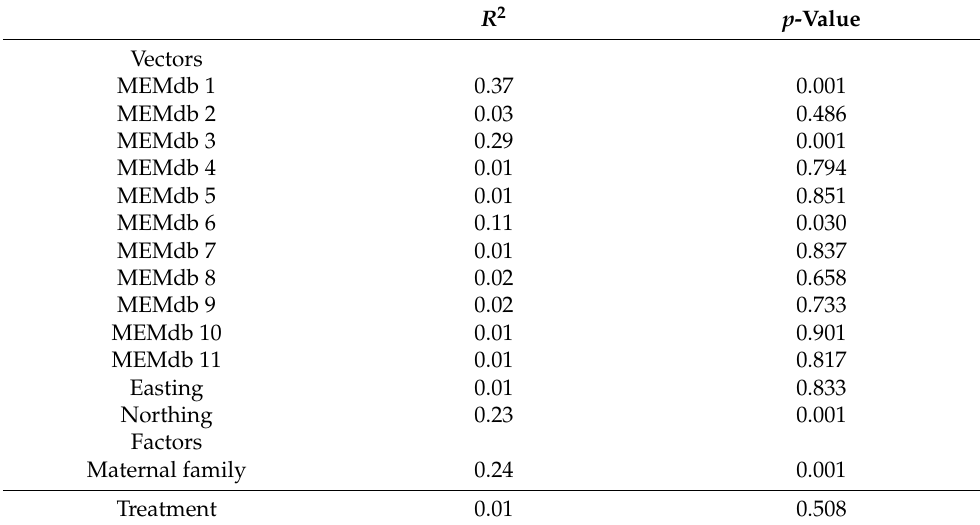
Table 3. Results of vector (quantitative variables) and factor (categorical) fitting to the NMDS projec- tion (Figure 4), 999 permutations used. Statistically significant results are shown in boldface type. R 2 p -Value